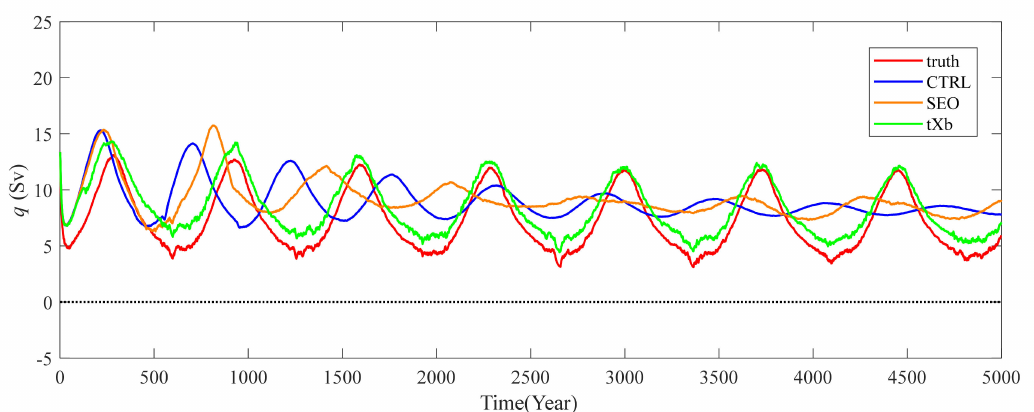
Figure 9. Time series of state means of the MOC q . CTRL (blue line), SEO (orange line) and tXb (green line) are compared with the true values (red line) for 5000 years running in the imperfect model, and the black dashed line indicating that q equals 0 is the dividing line between the two equilibrium